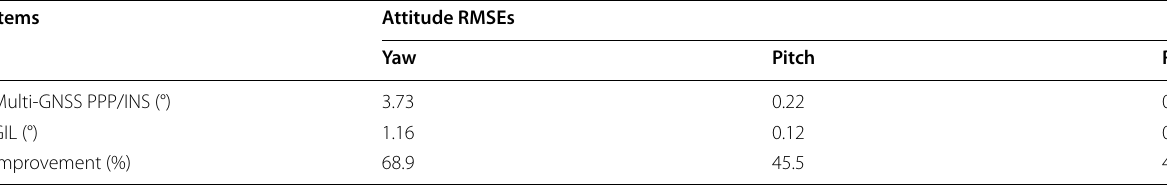
Table 9 RMSEs of attitude for PPP/INS and GIL solutions in GNSS difficult experiment Items Attitude RMSEs